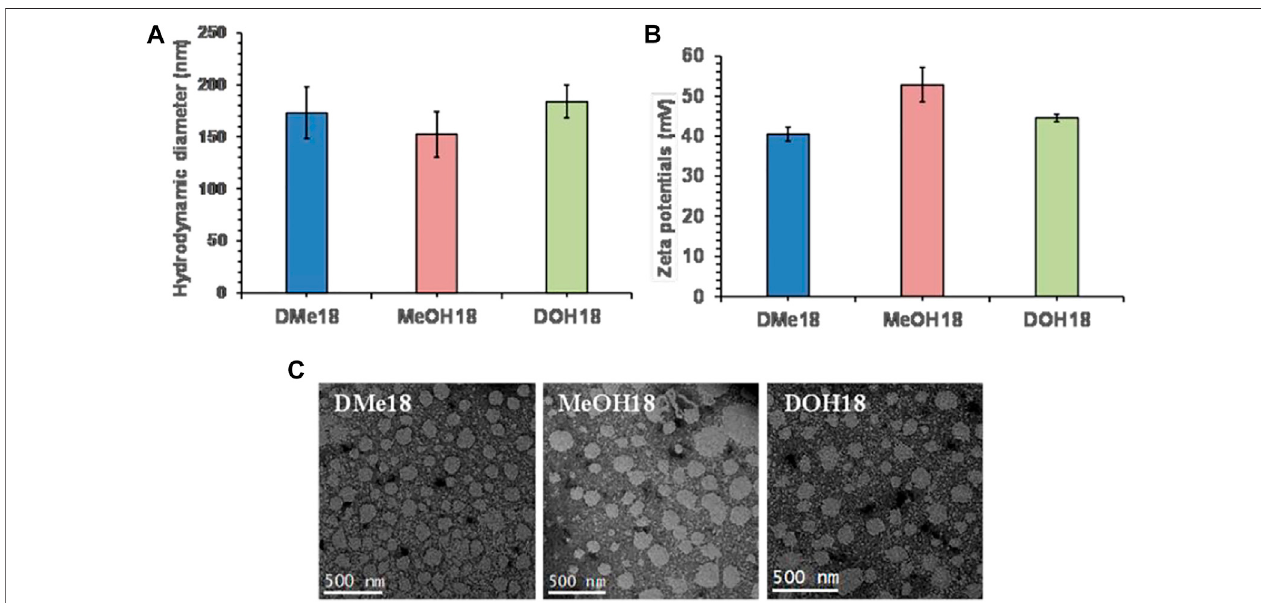
FIGURE 1 | Physicochemical characterization of amide linker-based cationic lipid-associated liposomes. (A) Hydrodynamic diameter and (B) surface potentials of Lipo-DME, Lipo-MeOH, and Lipo-DOH liposomes in Milli “ Q ” water and (C) transmission electron microscopic analysis of three different liposomal formulations (Scale bar 500